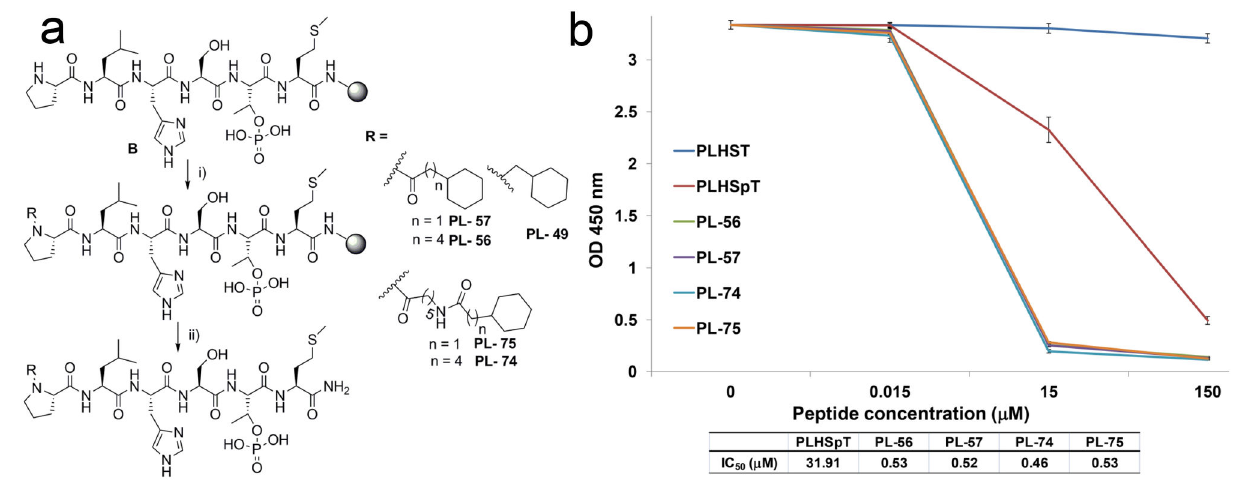
Figure 4. First-phase diversification of peptides, and quantification of their inhibitory activities against Plk1 PBD. (A) First- phase N- terminal-truncated peptides generated using solid-phase peptide synthesis (SPPS). i) R-COOH, HBTU, HOBt, DIPEA, DMF, 2 h; ii) TFA/TIS/H O (90:5:5), 2.5 h; (B) ELISA-based Plk1 PBD-binding assay result using first-phase N- terminal-truncated 2 peptide derivatives. Representative graphs from three independent experiments are shown (O.D., optical density). doi: